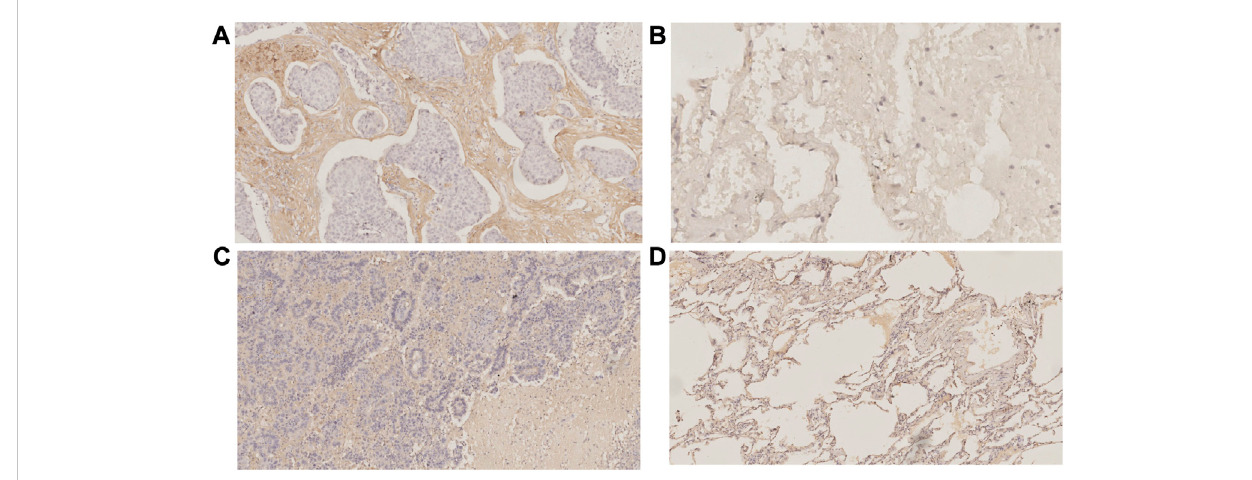
FIGURE 12 Immunohistochemistry (A) COL1A1 expressed in tumor tissues (B) COL1A1 expressed in normal tissues (C) EPHB2 expressed in tumor tissues (D) EPHB2 expressed in normal tissues.